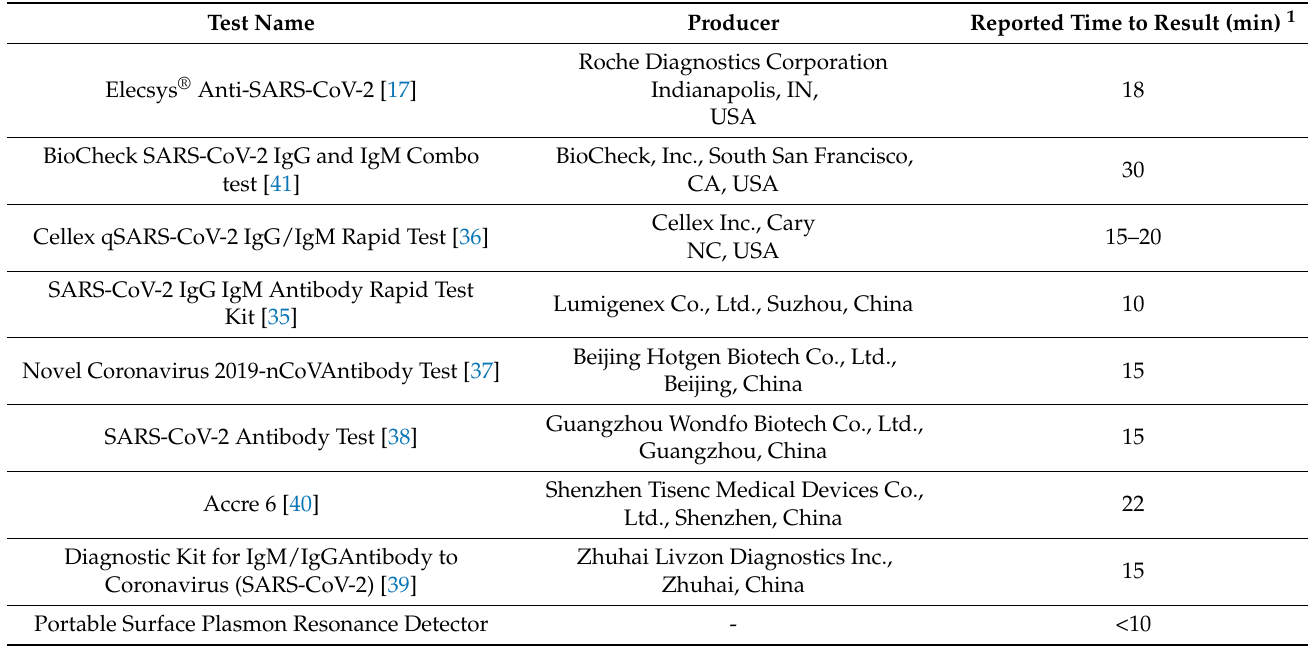
Table 3. Comparison of detection time for single sample between present system and commercially available antibody detection kits for